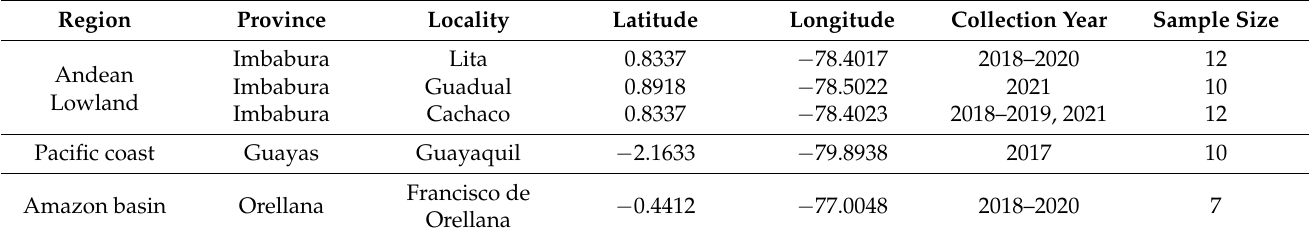
Table 1. Collecting sites for Aedes albopictus individuals in tropical and subtropical regions of